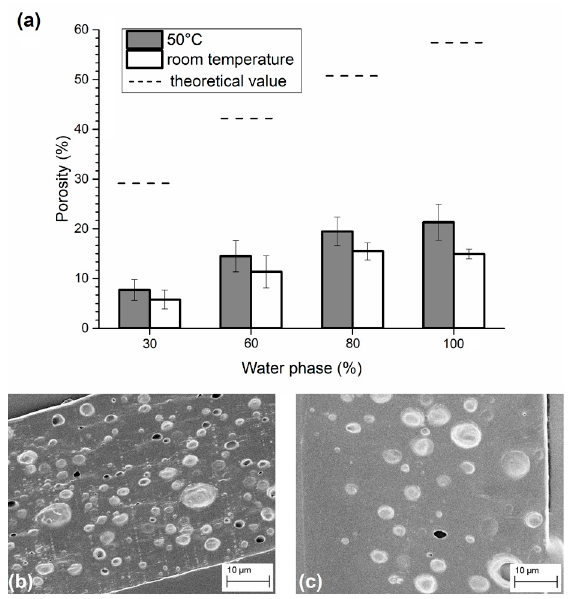
Figure 1. ( a ) Porosity obtained in emulsions containing different amounts of water phase and consolidated at 50 °C or at room temperature. SEM images of sliced matrices obtained from emulsions with 80% of water phase and solidified at ( b ) 50 °C; and ( c ) at room temperature.